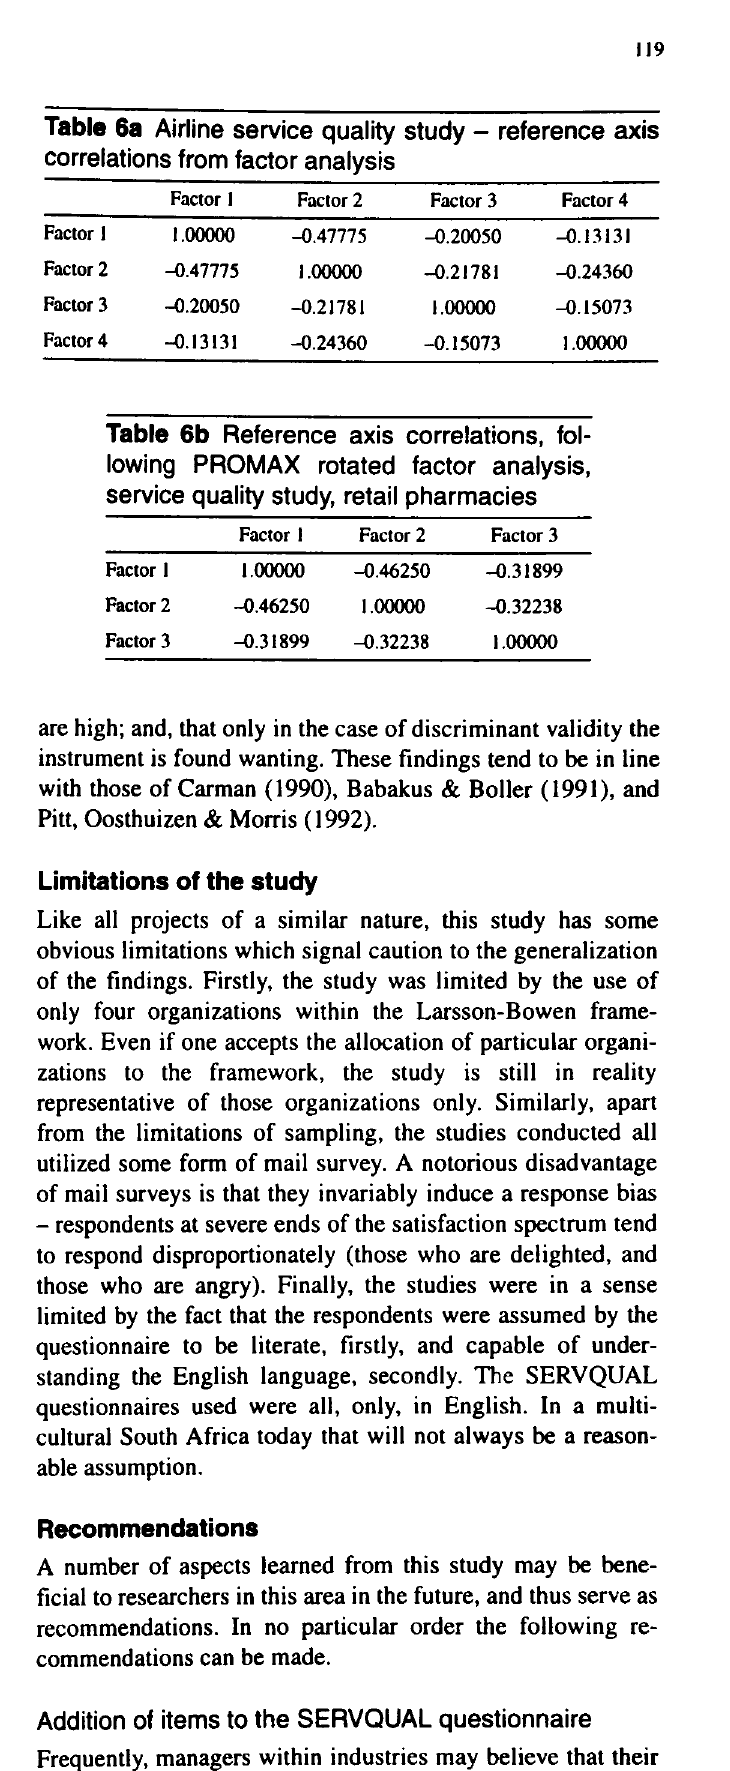
Table &b Reference axis correlations, fol lowing PROMAX rotated factor